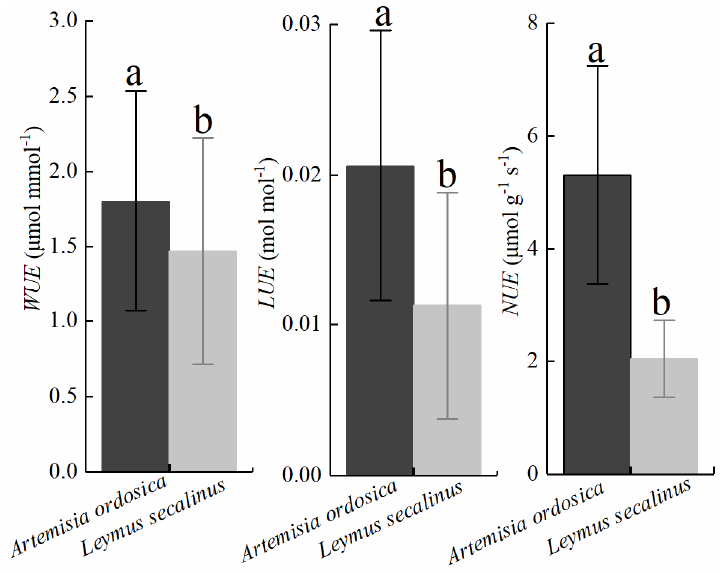
Figure 9. Pairwise comparisons of WUE , LUE , and NUE for A. ordosica and L. secalinus. Different letters (a and b) indicate statistically significant differences by paired, student t-tests based on a critical probability of 0.01.